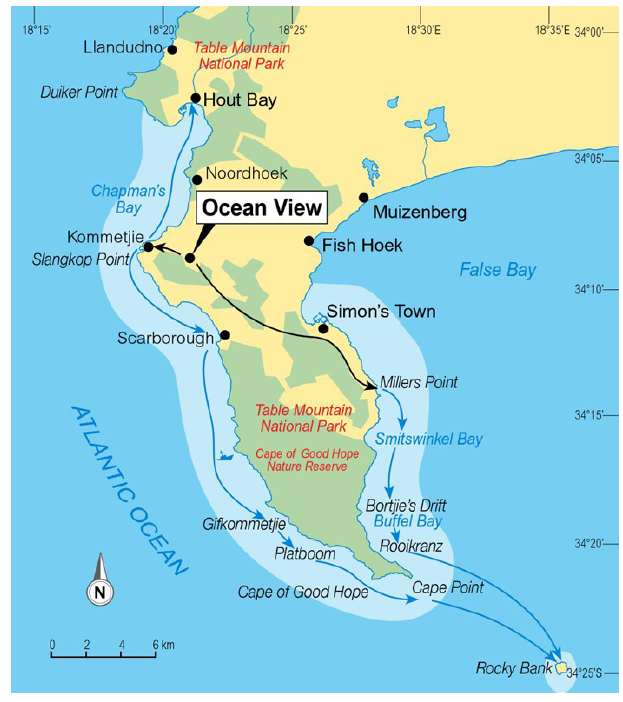
Fig. 2 . Primary Thyrites atun (Snoek) fishing spots around the Cape